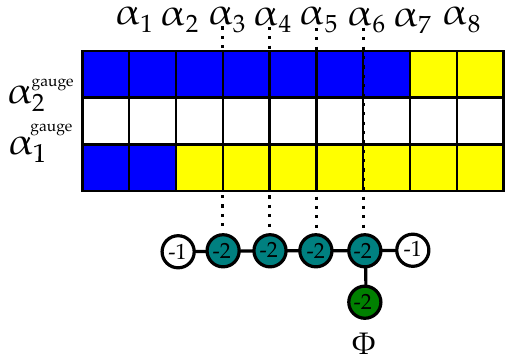
Figure 29. The BG-CFD of the SU(3) gauge theory presented in (cid:12)gure 5, including the additional node, inferred from the geometric data. The non-abelian part of the superconformal (cid:13)avor symmetry is determined by the ( (cid:0) 2) (marked/green) vertices, and is SU(6). The mass deformations that lead to new SCFTs with e(cid:11)ective SU(3) gauge descriptions are indicated in terms of the ( (cid:0) 1) vertices, to which we can apply CFD-transitions. While it is not the full CFD, this reduced CFD, contains the same marked subgraph, and the ( (cid:0) 1) vertices of the reduced graph are also present in the full CFD, which are the central ingredients for the (cid:13)avor symmetry and the descendant